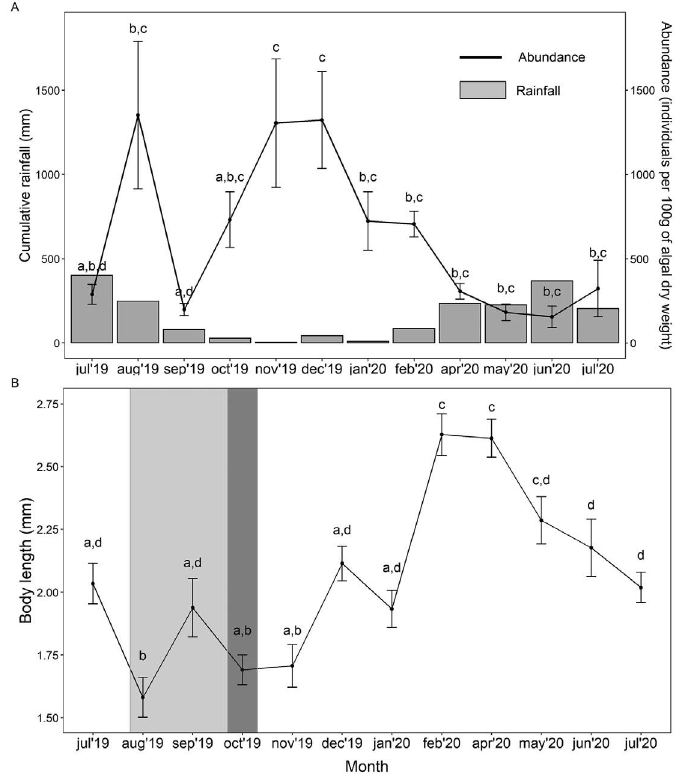
Fig. 2. – A, abundances of Chondrochelia dubia between July 2019 and July 2020 (black line) and cumulative rainfall (grey bars). B, body length (mm) of C. dubia between July 2019 and July 2020. The light grey rectangle indicates the period of weak oil arrival at the location (August and September 2019) and the dark grey rectangle indicates the period of strong oil arrival (October 2019). Vertical bars represent standard errors and letters indicate the results of Tukey tests